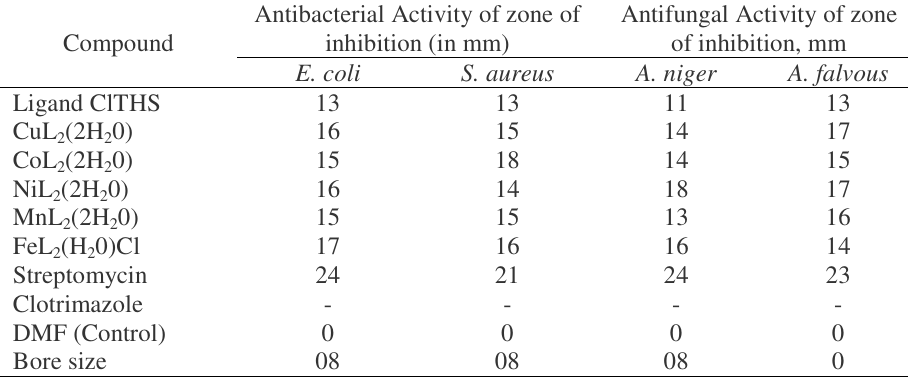
Table 5. Antimicrobial activity of the ligands ClTHS and its